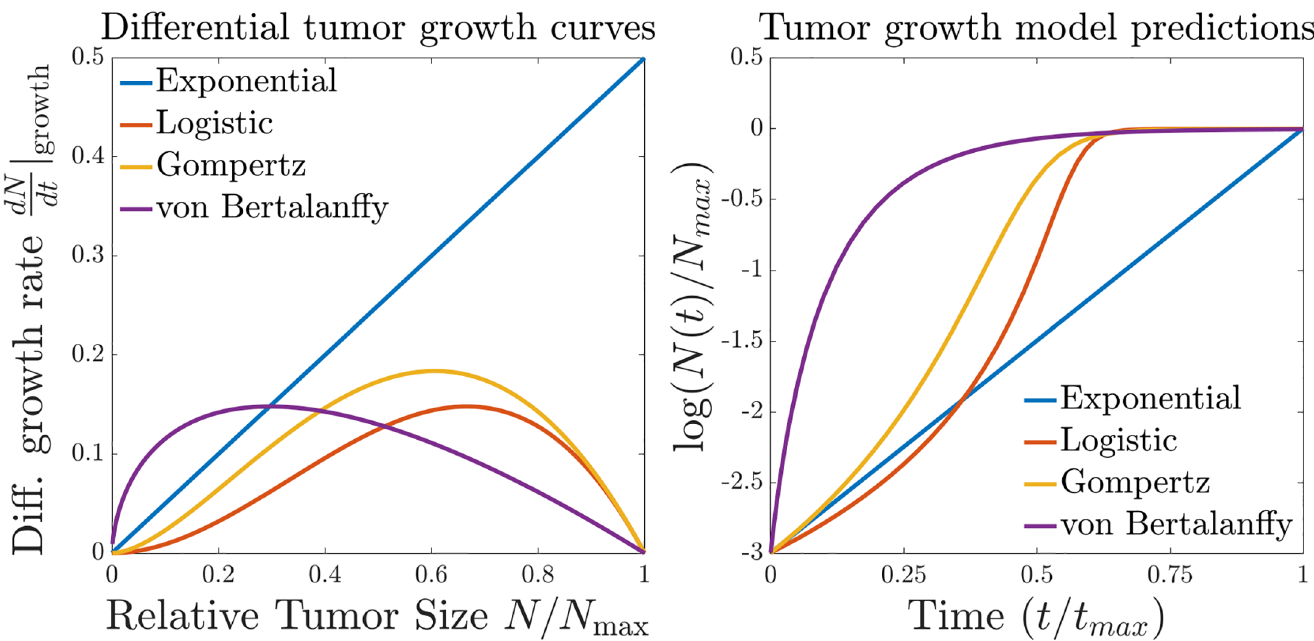
Fig 3. Tumor growth curves. A comparison of several differential growth curves of the form N F ( N ).Note that in each case except unbounded exponential growth, the differential growth rate goes to zero as the tumor approaches its maximum size.